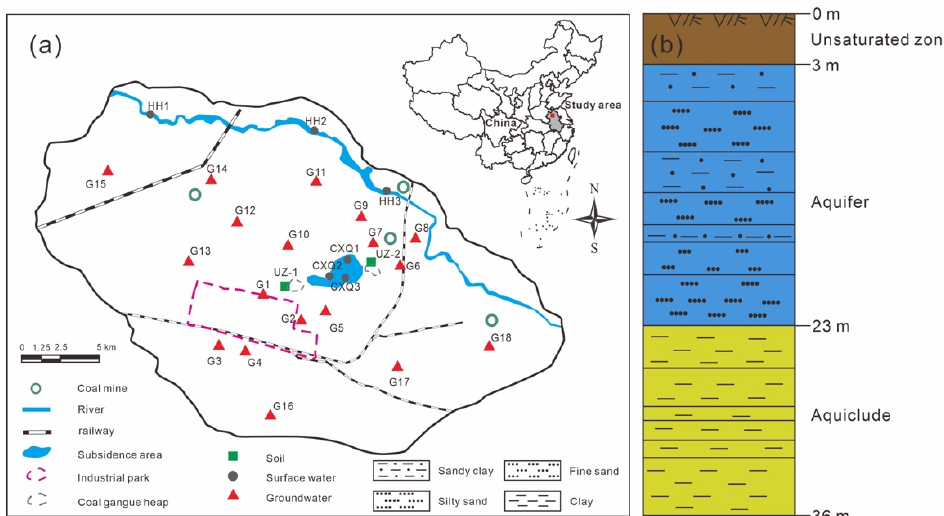
Figure 1. ( a ) Map of the study area. Surface water, groundwater, and soil samples are shown as gray closed circles, red closed triangles and green closed squares, respectively. The coal mining area is shown as blue open circles. ( b ) Hydrogeological cross section of the study area. The unsaturated zone, the first aquifer and the first aquiclude mainly occur at depths of 0 − 3 m, 3 − 23 m and 23 − 36 m in the unconsolidated Cenozoic strata.